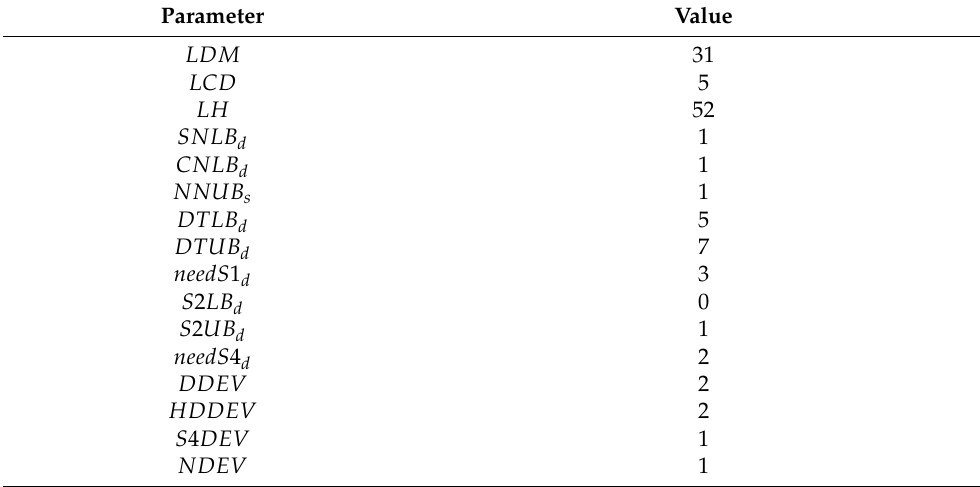
Table 3. System parameters.